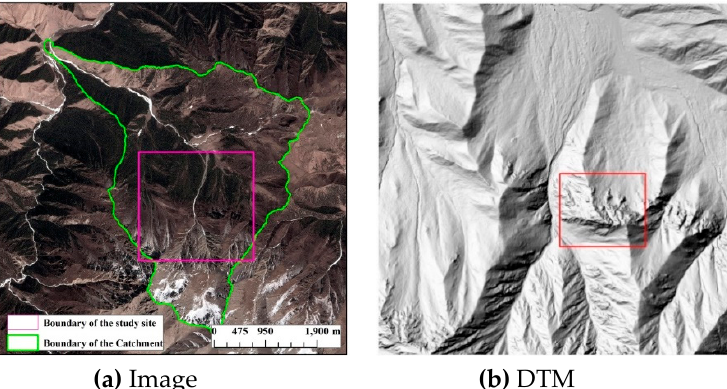
Figure 9. ( a ) Image and ( b ) DTM of the study site. The area denoted by the red rectangle in ( b ) will be taken as an example to show the DTMs produced by the interpolators.